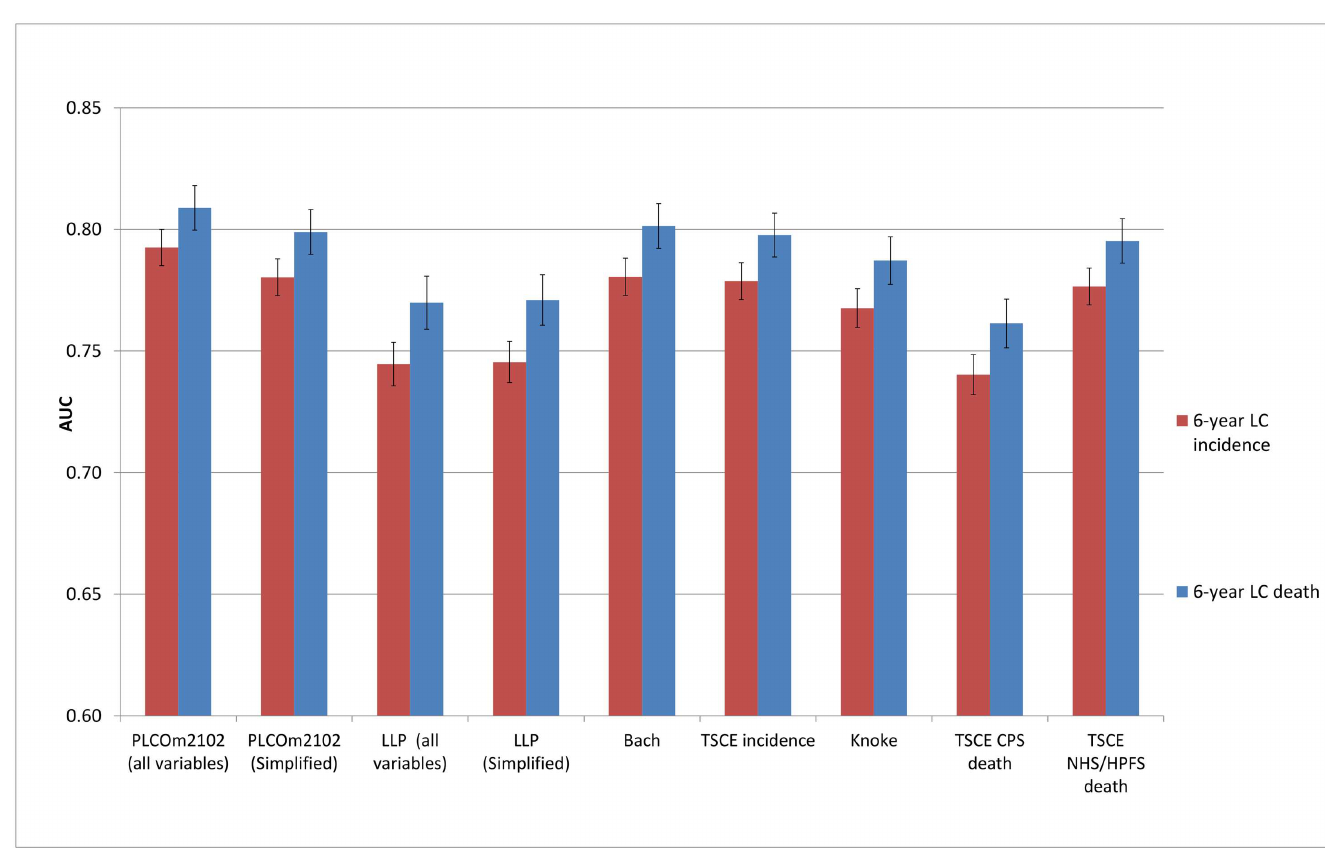
Fig 4. Area under the receiveroperating characteristic curve of the investigated risk models (with 95% confidence interval) in the Prostate, Lung, Colorectal and Ovarian CancerScreening Trial chest radiography arm by predicted outcome. AUC, area under the receiveroperating characteristic curve; CPS, Cancer PreventionStudy; HPFS, Health Professionals Follow-upStudy; LC, lung cancer; LLP, Liverpool Lung Project; NHS, Nurses’ Health Study; TSCE, Two-Stage